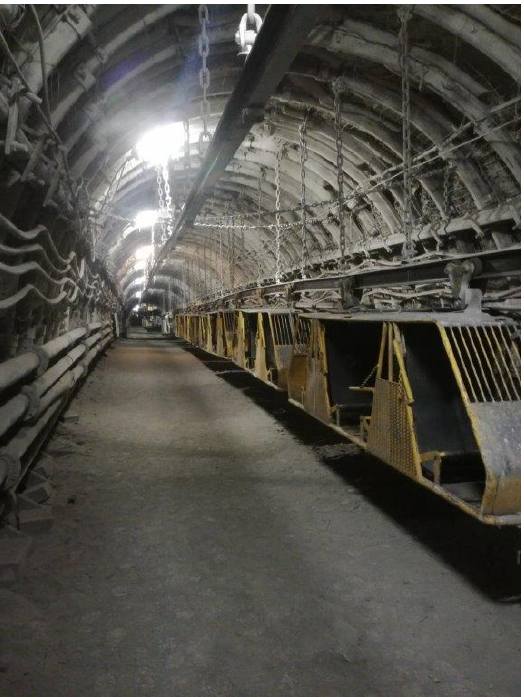
Figure 1. Crew transport system using a suspended railway (Dawid Osowski, Lubelski W ę giel “Bogdanka” S.A.).